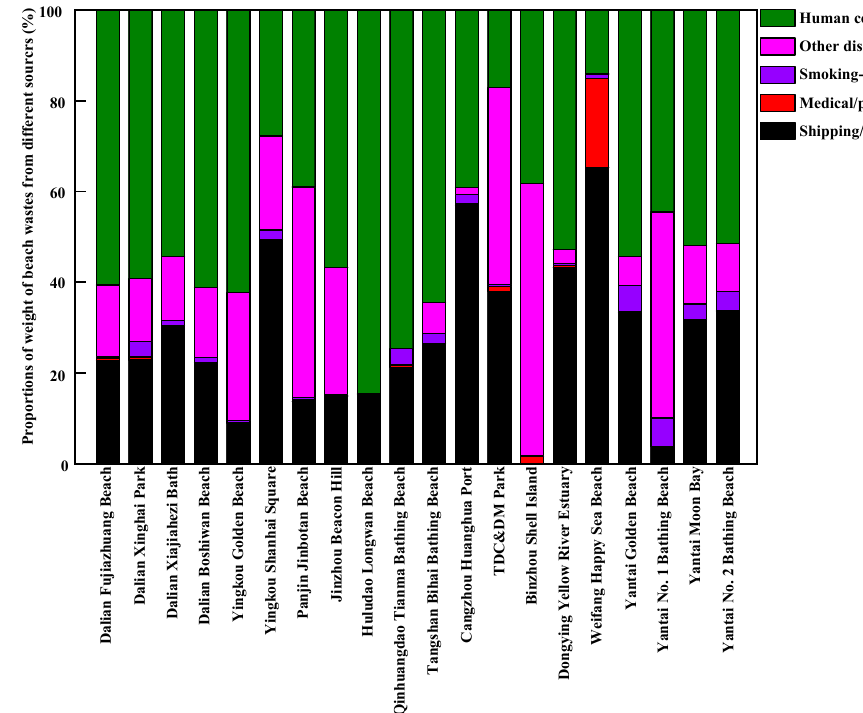
Figure 8. The proportions of beach waste from different sources in coastal cities around the Bohai Sea of China in the tourist off-peak season, by weight.